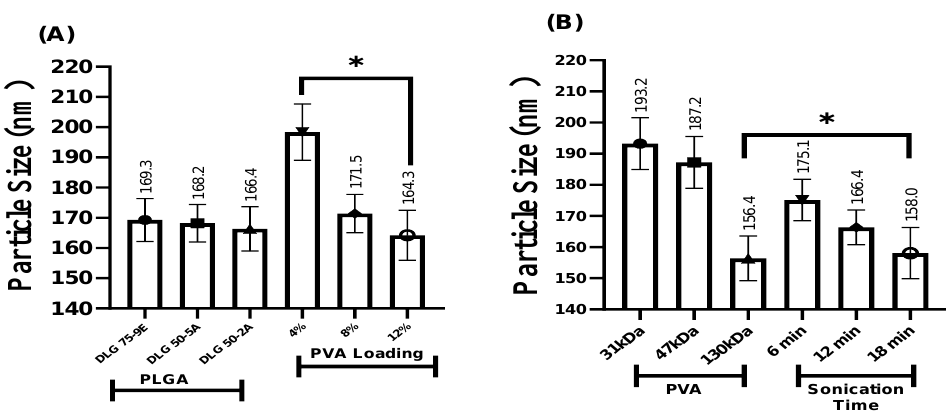
Figure 2. Particle size (A and B) 10% w/w 5-FU loaded PLGA nanoparticles. * indicates a significant